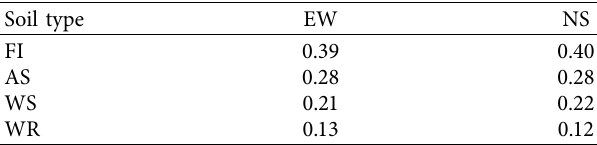
Table 6: The periods ( T f ) where the peak appears in free-field response spectrum for each soil type in different direction (unit: